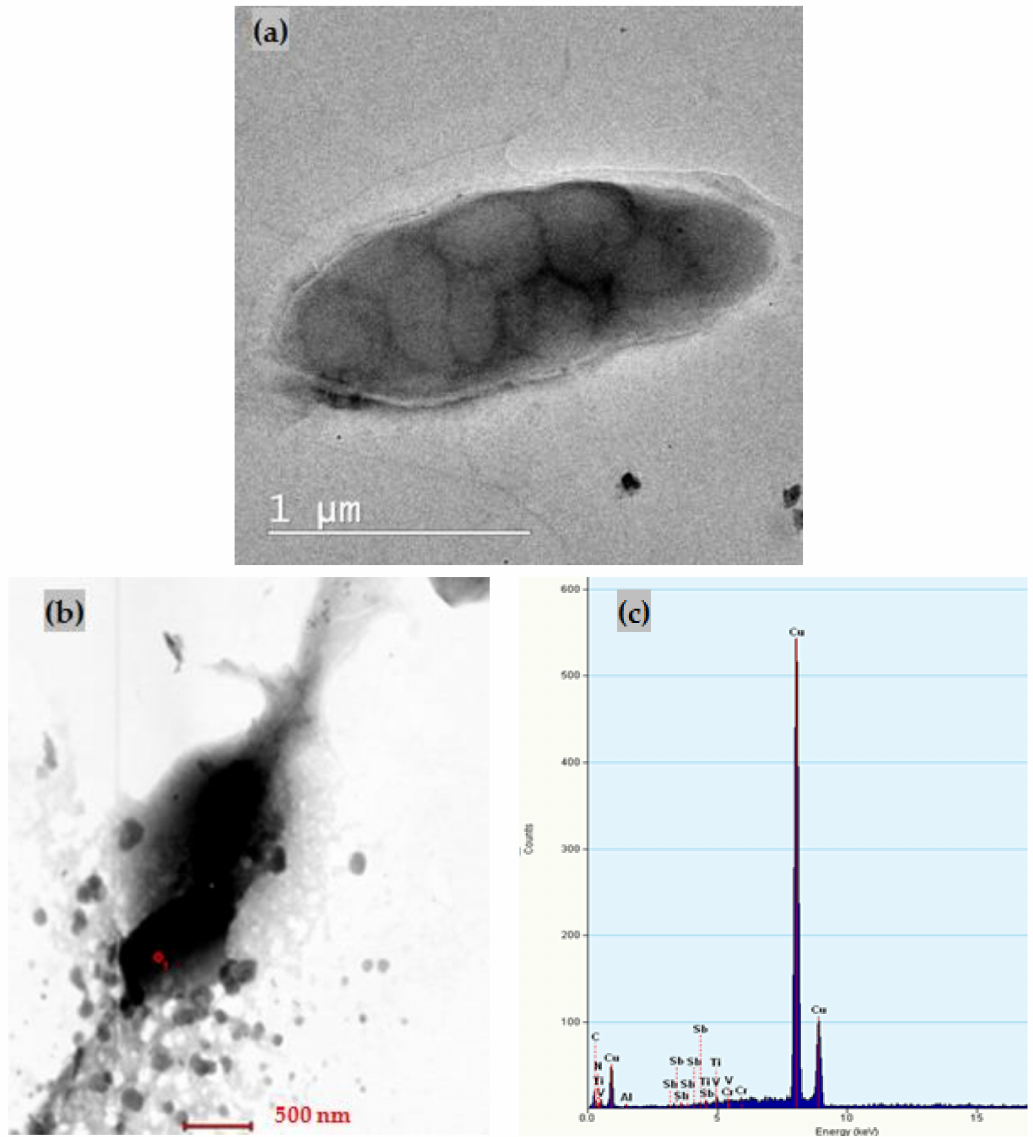
Figure 4. ( a ) TEM micrograph of ox-xGnP before adsorption of Sb; ( b ) STEM image of ox-xGnP after adsorption of Sb; ( c ) EDX analysis of ox-xGnP after adsorption of